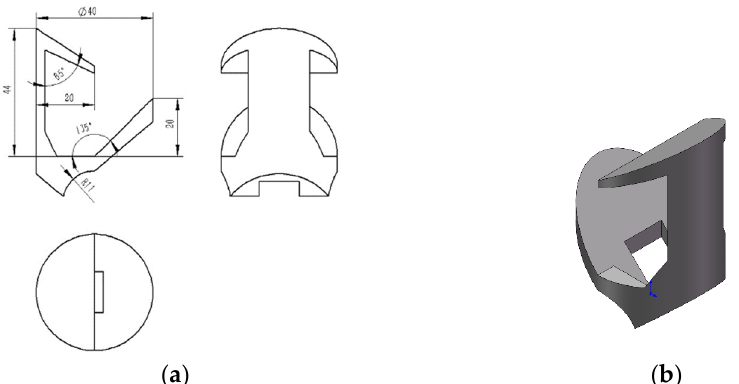
Figure 17. Shape and size of the inverted hook. ( a ) Two-dimensional view. ( b ) Three-dimensional view.